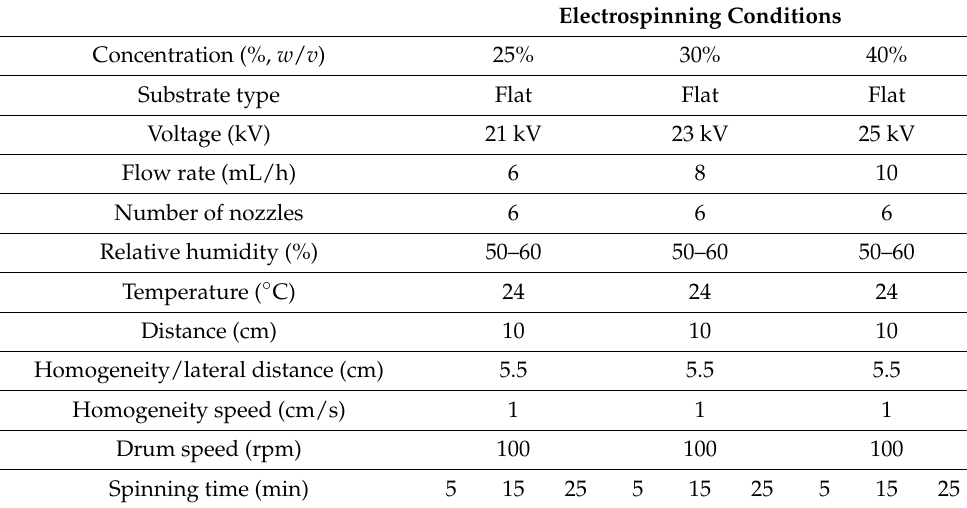
Table 1. Electrospinning conditions for varying zein